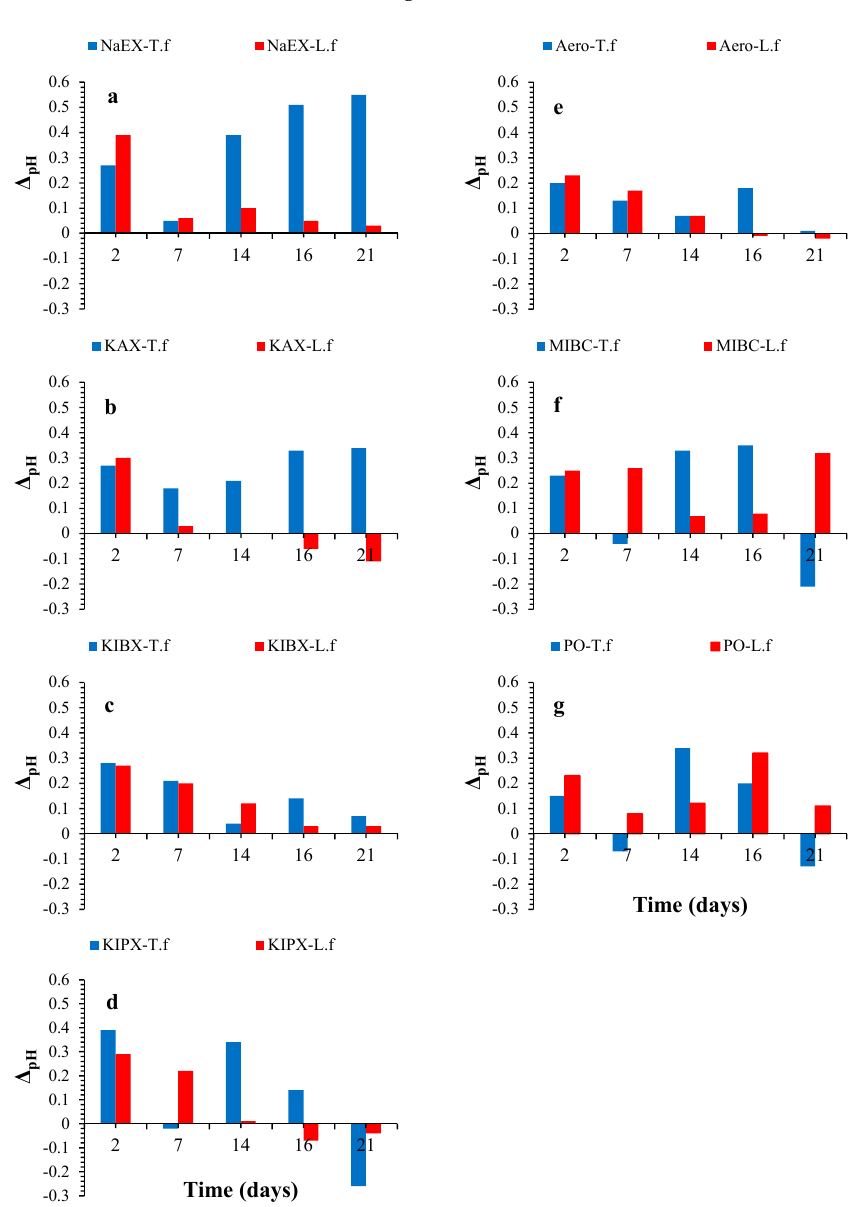
Figure 1. Effects of various flotation reagents on pH during L. ferrooxidans and A. ferrooxidans activities.